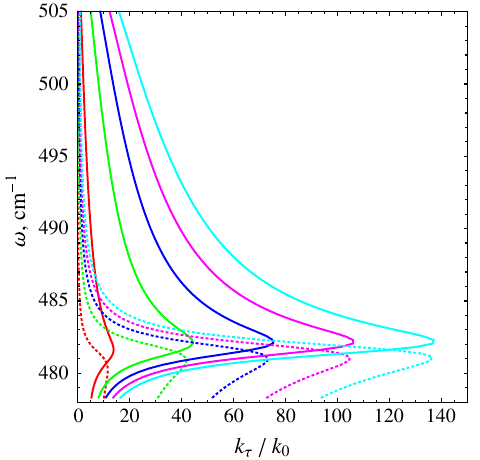
FIG. 11. The dispersion diagrams for the first five surface waves at the interface of air and the silicon-sapphire hypercrystal (same as in Figs. 9 and (10)), with the actual loss. The solid and dashed lines correspond, respectively, to the real and imaginary parts of the in-plane momentum k τ